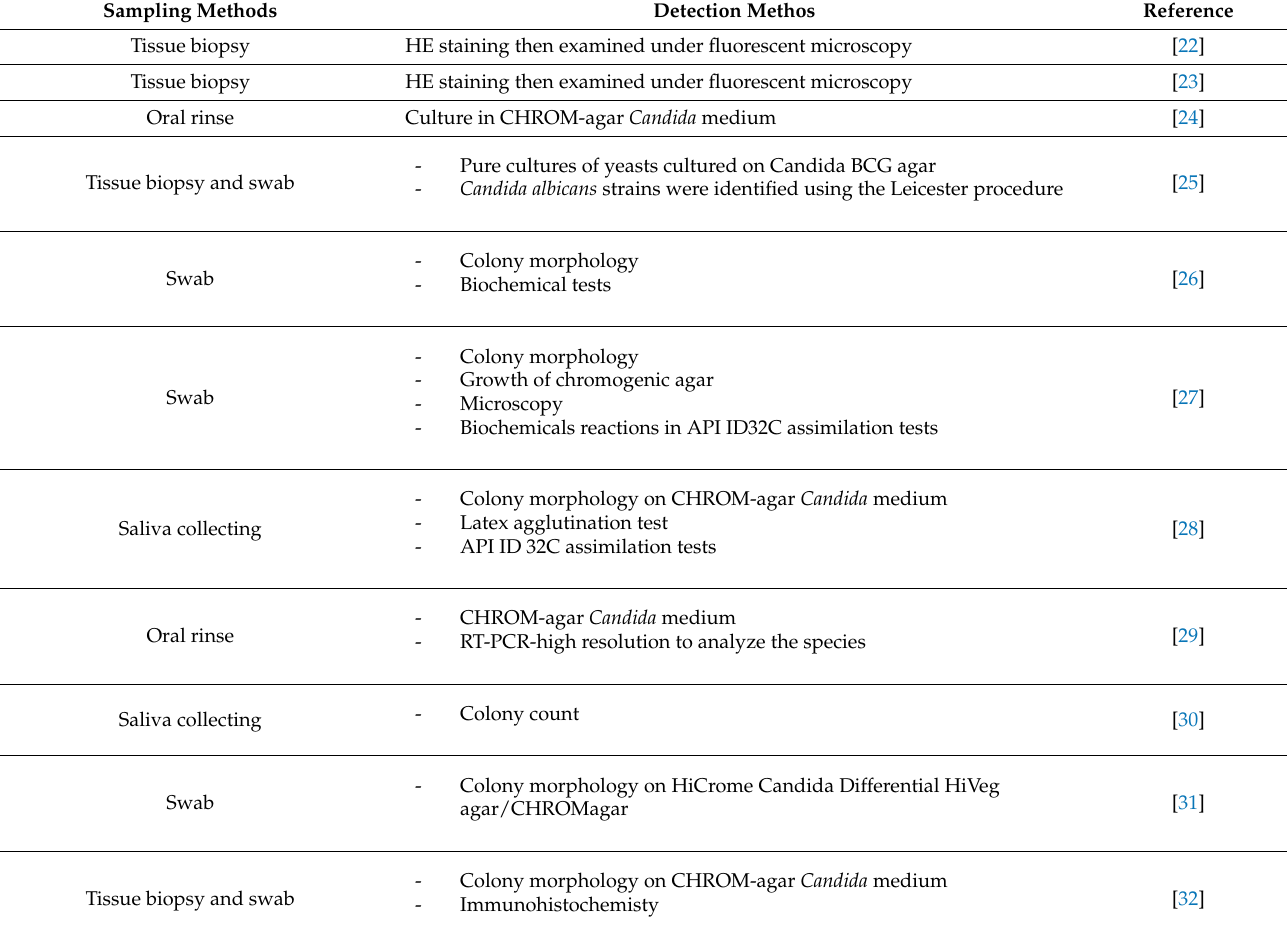
Table 2. The Candida albicans isolation and the diagnosis